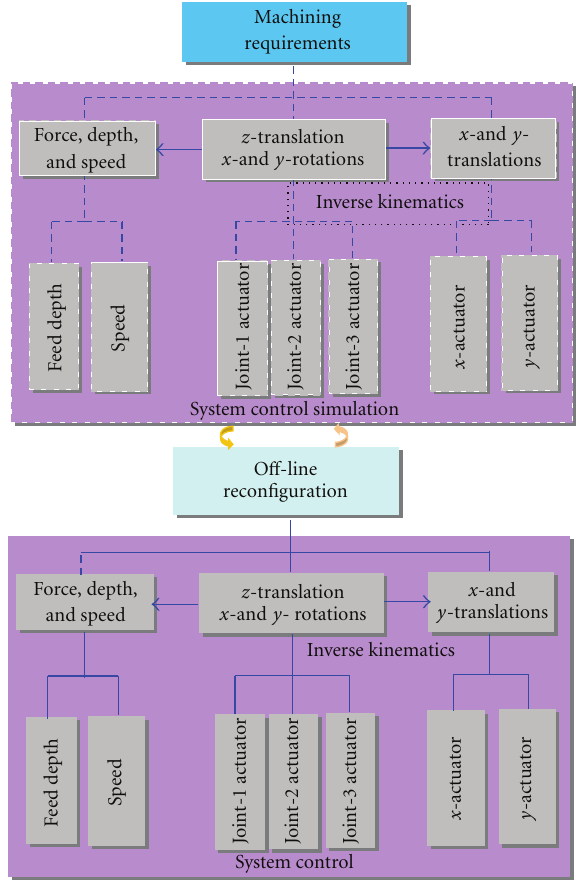
Figure 6: Control Architecture of Reconfigurable Machine Tool.